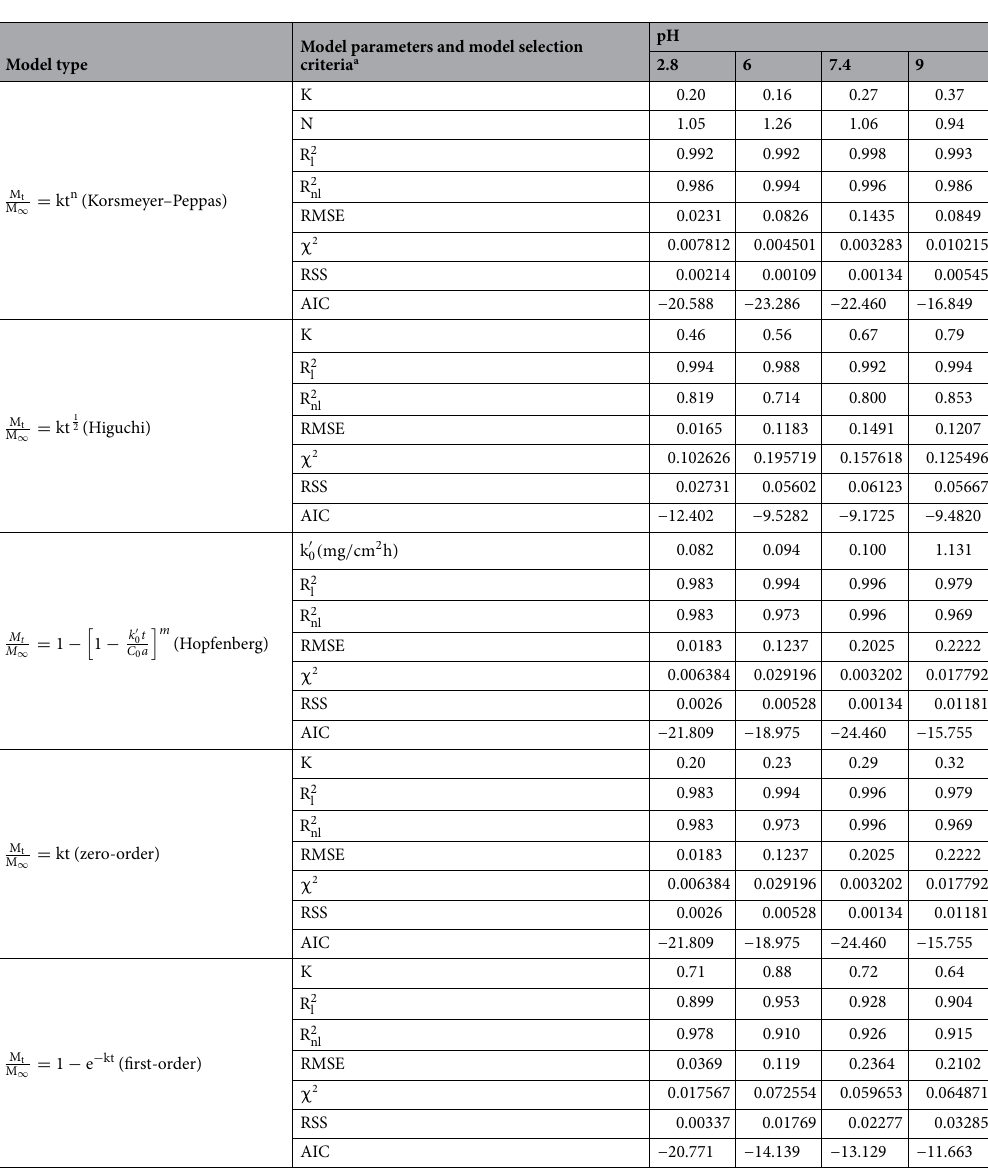
2 l : coefficient of